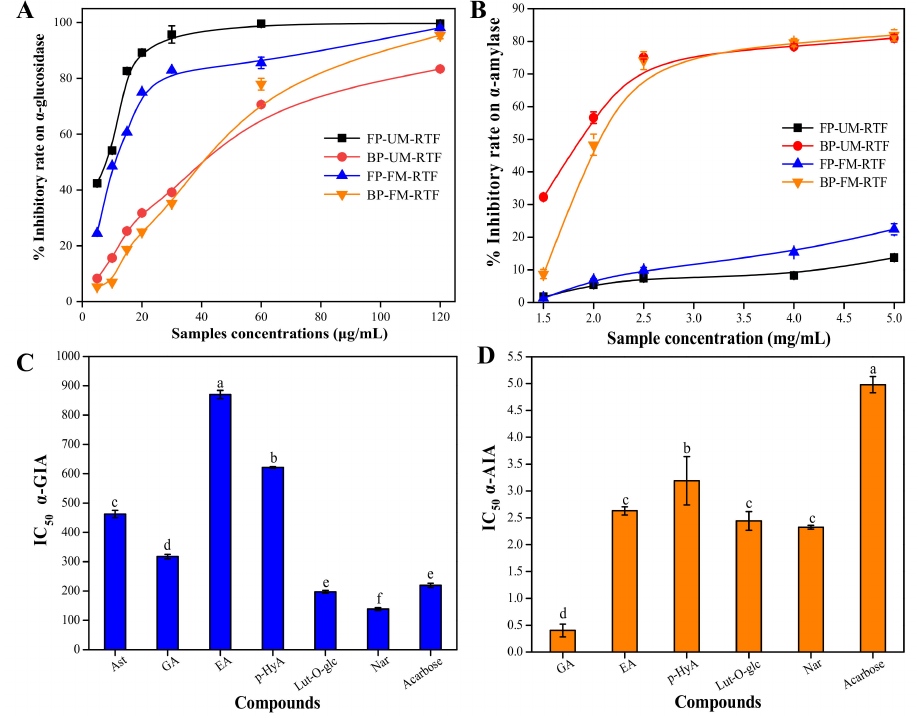
Figure 2. The inhibitory activities of different extracts fractions in RTF on digestive enzymes: α - glucosidase ( A ) and α -amylase ( B ). ( C , D ) shows the IC 50 values of the major phenolics in RTF and acarbose against α -glucosidase/ α -amylase. One-way ANOVA was used to evaluate the statistical analysis. Different lowercase letters (a–f) mean statistically significant difference ( p < 0.05) in α - glucosidase/ α -amylase inhibitory activity of the major compounds. FP-UM-RTF, free phenolic fraction of un-fully mature R. ulmifolius fruits; BP-UM-RTF, bound phenolic fraction of un-fully mature R. ulmifolius fruits; FP-FM-RTF, free phenolic fraction of fully mature R. ulmifolius fruits; BP- FM-RTF, bound phenolic fraction of fully mature R. ulmifolius fruits; Ast, astragalin; GA, gallic acid; EA, ellagic acid; p -HyA, p -hydroxycinnamic acid; Lut- O -glc, luteolin-7- O -glucoside; Nar, naringenin; α -GIA, α -glucosidase inhibitory activity; α -AIA, α -amylase inhibitory